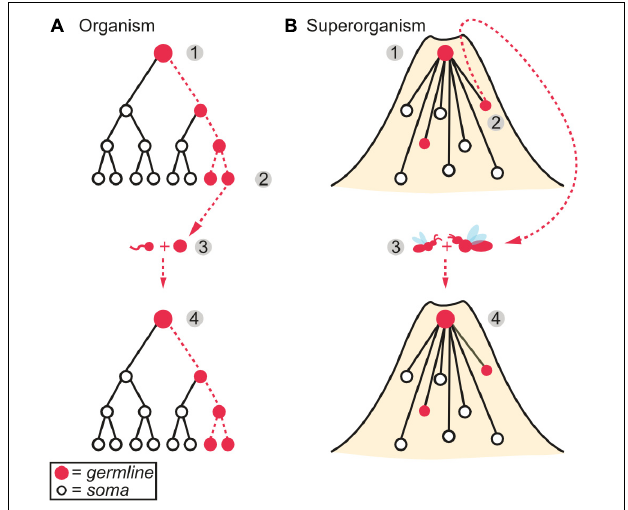
FIGURE 1 | Analogous features between (A) multicellular organisms and (B) social insect superorganisms. (1) An organismal/colony existence is obligate with distinct germline (red dots) and soma (white dots) roles. The germline gives rise to both the sterile soma and additional germline entities. (2) The germline reproduces the (super)organism. (3) Lifetime commitment, through the fusion of gametes as a zygote in organisms and strict lifetime monogamy between mated pairs in superorganisms, creates the conditions necessary for the evolution of germline-soma differentiation, which in many, but not all, metazoan and superorganismal lineages has also become fully sequestered (see main text). (4) Superorganism fitness, akin to the fitness of an organism, is measured not by the number of new insects it creates, but by the number of new, independent superorganisms it